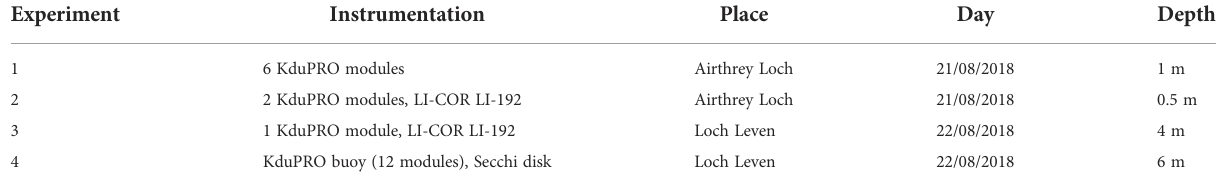
TABLE 1 List of experiments done with the